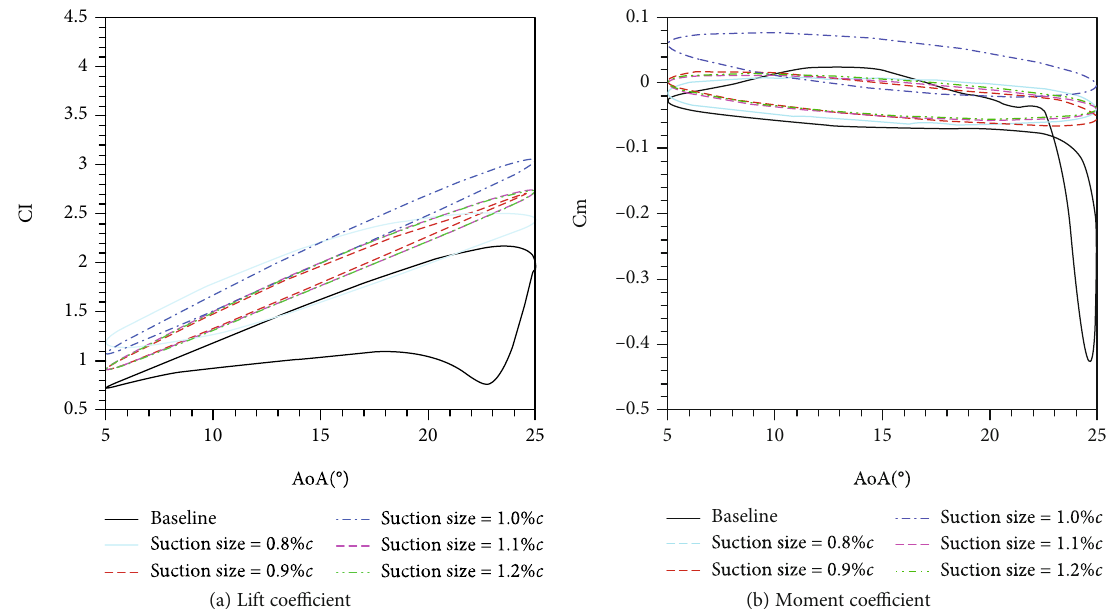
Figure 17: Hysteresis curves of the lift and moment coe ffi cients with the AoA under di ff erent suction slot sizes.